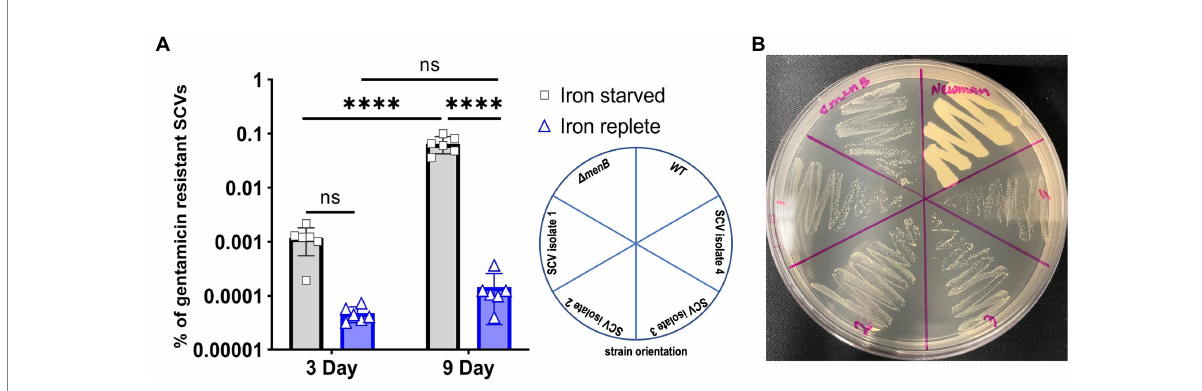
FIGURE 4 Iron starvation promotes increased rates of stable SCV emergence over time. (A) The respiring Staphylococcus aureus increased the number of gentamicin-resistant SCVs with the treatment by DIP. Each of the data points on the graph represents one of six replications that were passaged for 9 consecutive days. Error bars indicate the standard deviation. A one-way ANOVA (Tukey’s multiple comparisons) was applied to determine the statistical significance of the differences (“ **** ” is the indication for p < 0.0001; “NS” is for non-significant data). (B) Representative plate assessing the subcultured phenotype of the stable, iron starvation-induced SCV isolates when grown on untreated TSA plates.